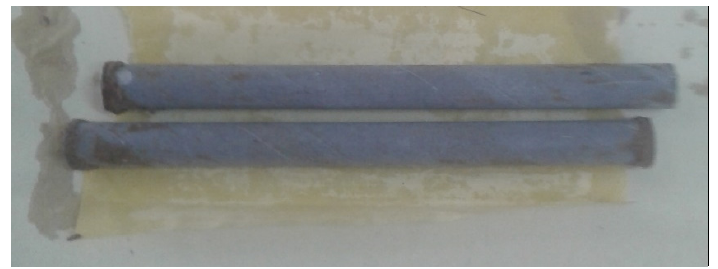
Figure 3. Armature Composite Material Fly ash.